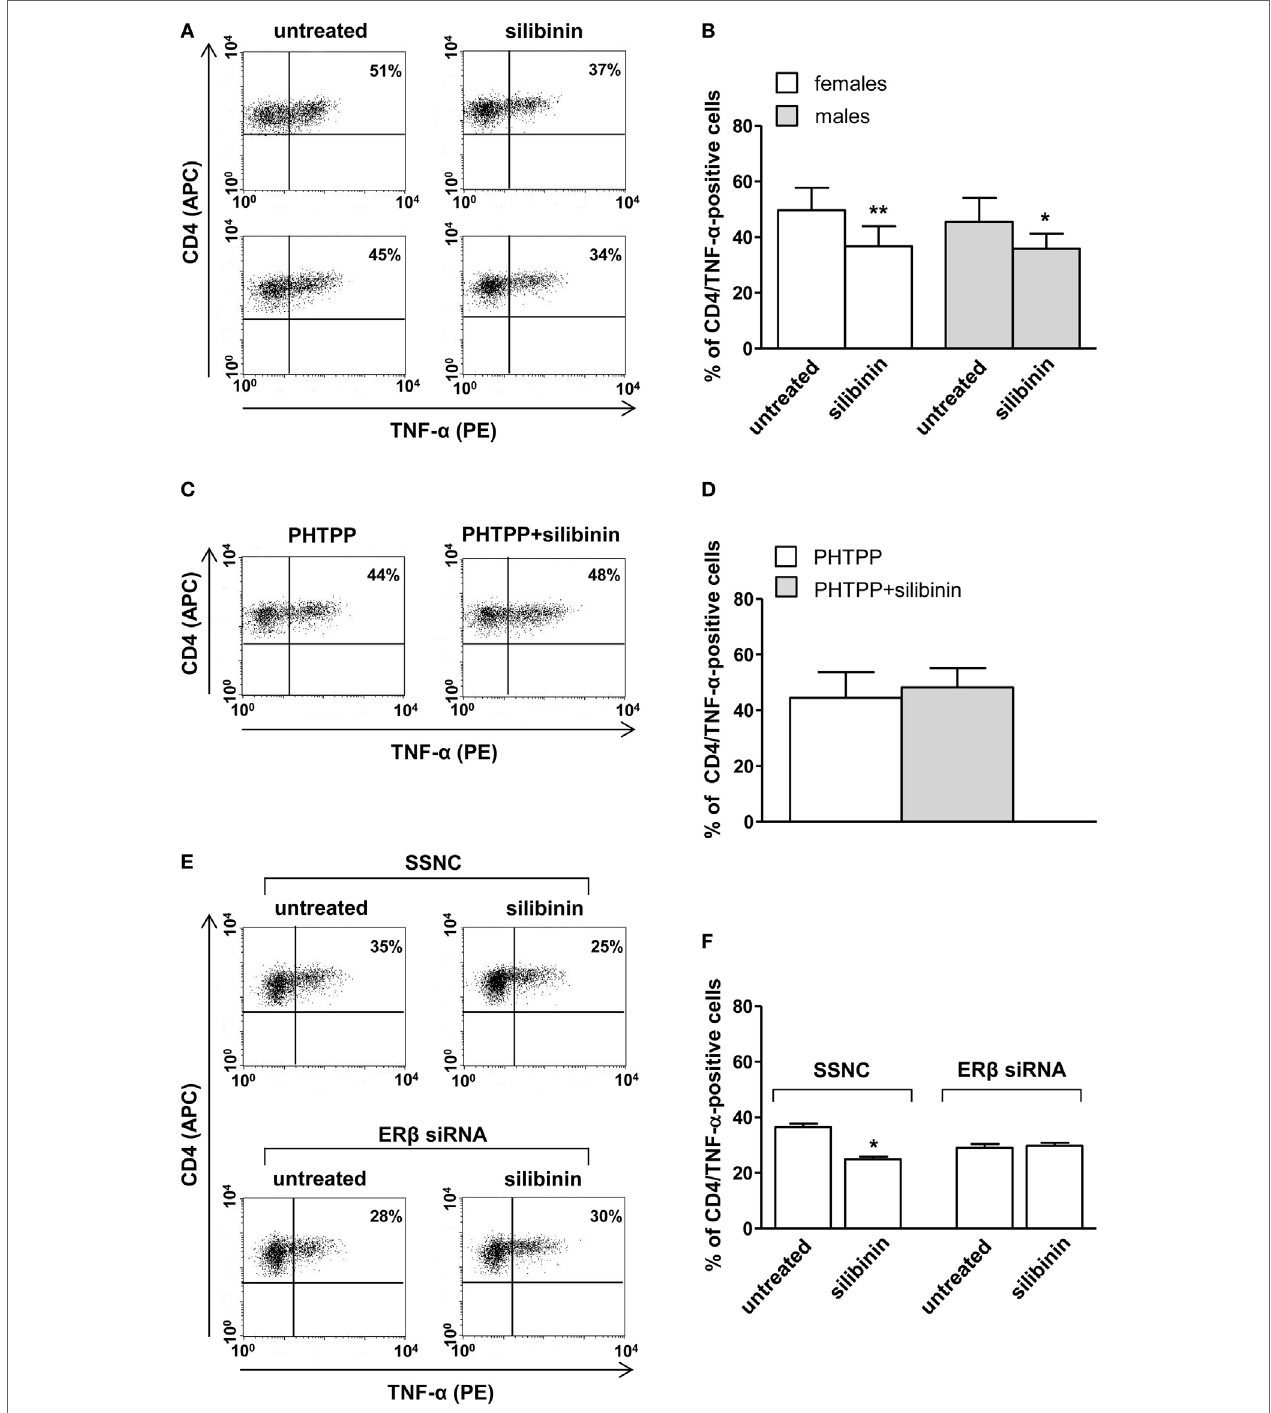
FigUre 4 | Silibinin decreased TNF- α expression in peripheral blood CD4 + T lymphocytes from female and male healthy subjects acting through ER β binding. (a,b) Cytokine expression were analyzed in 23 female and 21 male healthy subjects by flow cytometry after 48 h of culture with silibinin and stimulation with phorbol myristate acetate (PMA) and ionomycin in the presence of brefeldin for the last 16 h of culture as detailed in Section “Materials and Methods.” Results from representative female (upper panels) and male (lower panels) healthy donors are shown (a) . Data are also reported as mean ± SD (b) . (c,D) TNF- α expression was analyzed in T lymphocytes from three randomly selected female healthy donors pretreated with the ER β antagonist PHTTP for 1 h before adding silibinin. Results from a representative female healthy donor are shown (c) . Data are also reported as mean ± SD (D) . (e,F) TNF- α expression was analyzed in T lymphocytes from three randomly selected female healthy donors after silencing ER β expression. Results from a representative female healthy donor are shown (e) . Data are also reported as mean ± SD (F) . * P < 0.05, ** P < 0.01 versus untreated cells. Abbreviation: SSNC, silencer select negative control siRNA.